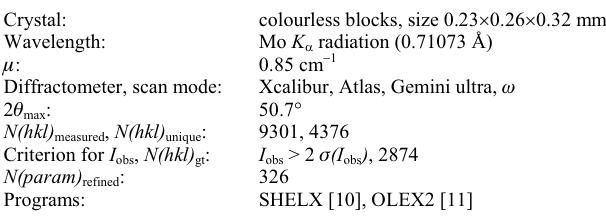
Table 2. Atomic coordinates and displacement parameters (in Å 2 )